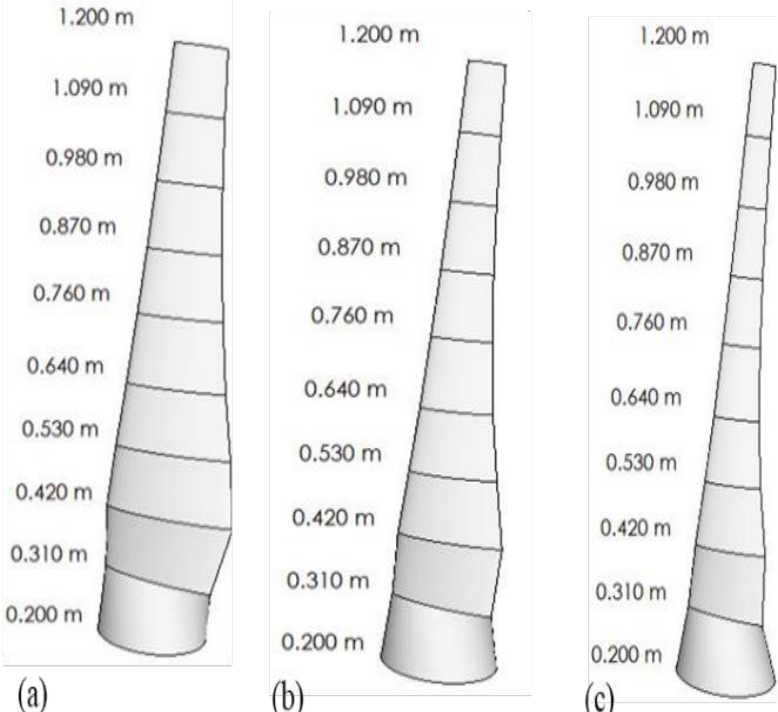
Figure 11. Optimum blade designed SG6043 airfoils for ( a ) TSR 4; ( b ) TSR 5; ( c ) TSR 6.